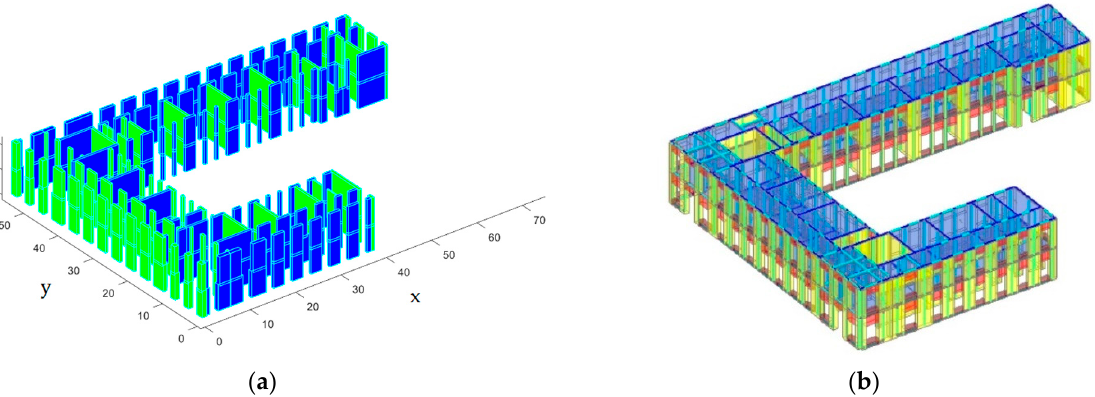
Figure 8. 3D layout of the structural models developed by means of: ( a ) E ‐ PUSH (dimensions in m), ( b ) Aedes PCM.